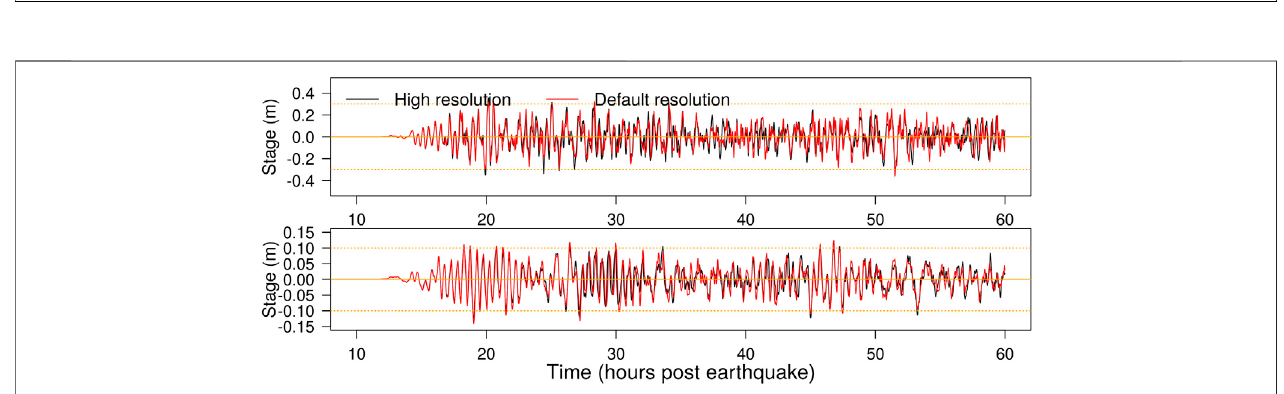
FIGURE4| Comparisonofnearshoregaugeresultsintwomodels;onewithdefaultresolution(1,1/7,1/49arc-minutenestedgrids)andonewithhigher-resolution (1/2, 1/14, 1/98 arc-minute nested grids). Locations correspond to tide-gauges at Port Kembla (top) and Botany Bay (bottom) ; results elsewhere were qualitatively similar. The simulation corresponds to the Tohoku 2011 Y18 source, using Manning-friction in the global model.